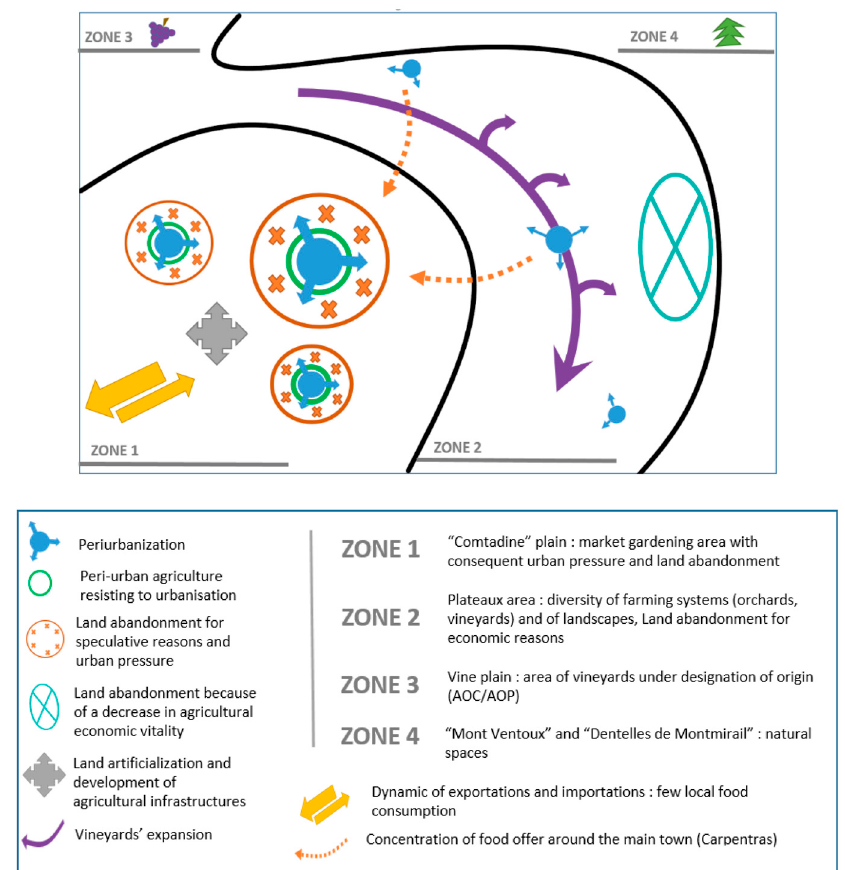
Figure 7. Synthetic and chromatic map of the